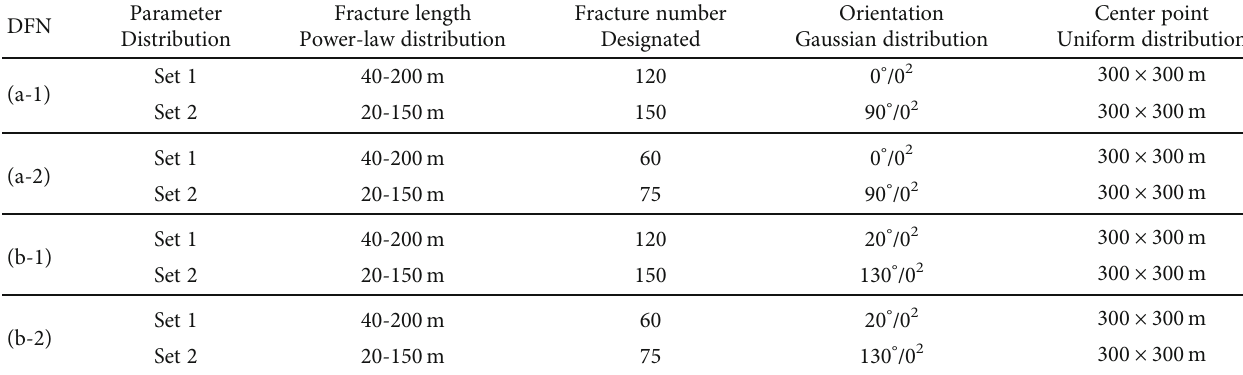
Table 1: Geometric parameters used for DFN